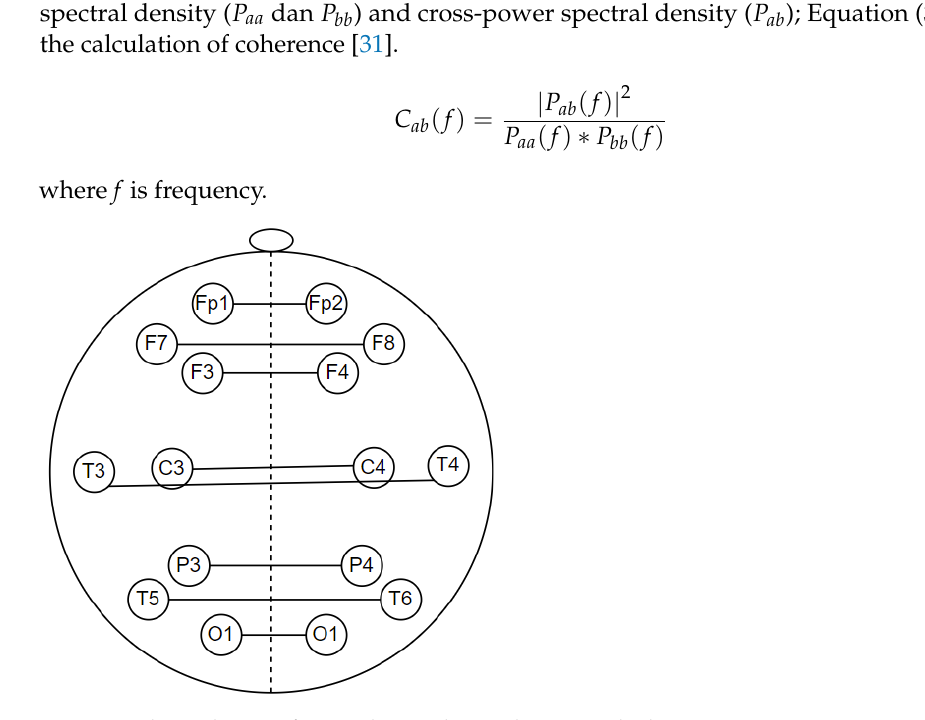
Figure 7. Electrode pairs for interhemisphere coherence calculations. Table 3. Interhemispheric and intrahemispheric coherence electrode pairs. Interhemispheric Left-Intrahemispheric